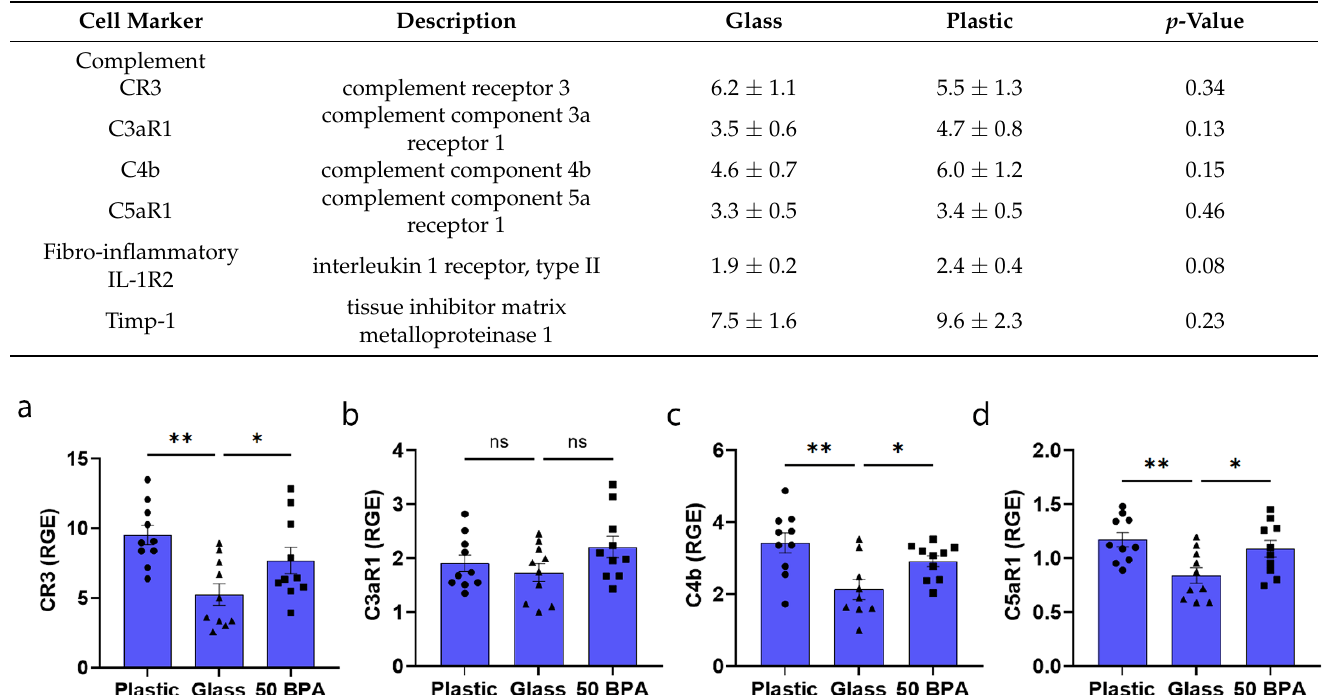
Table 1. Effect of plastic vs. glass caging on female mice on expression of complement and fibro-inflammatory markers in the heart using qRT-PCR.